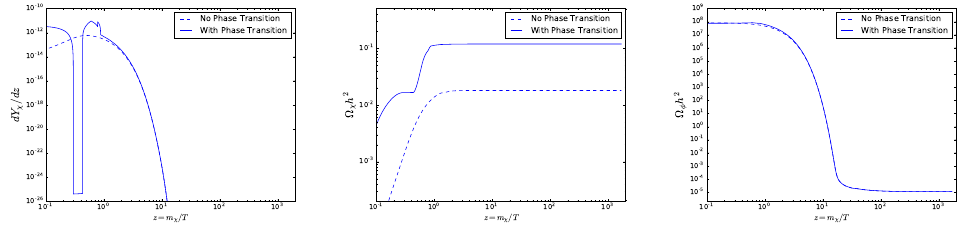
Figure 8 . The thermal corrected evolution of the number density of (cid:31) and (cid:30) for BP3 ( m (cid:30) = 170 GeV, m (cid:31) = 140 GeV, and m N = 40 GeV, (cid:21) h(cid:30) = 0 : 65, y D = 4 : 0 (cid:2) 10 (cid:0) 12